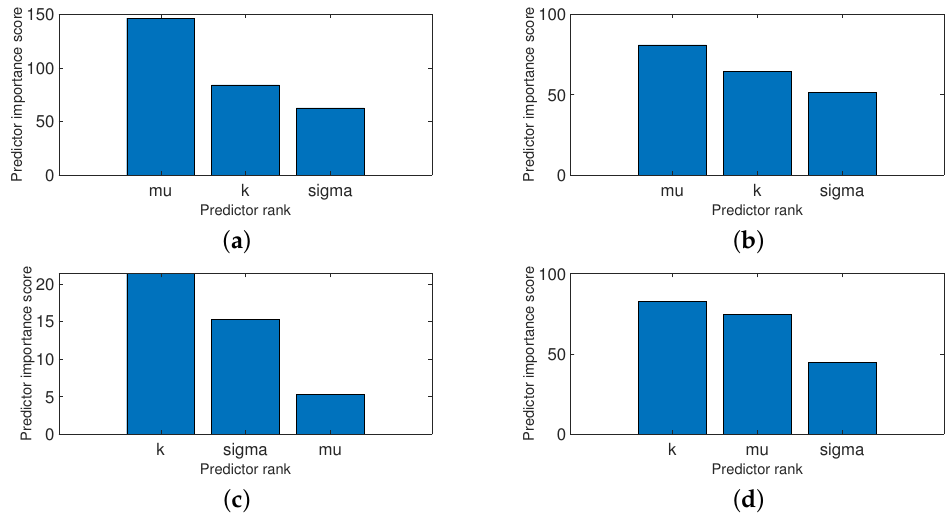
Figure 14. Feature ranking from the raspberries diseases and defects using statistical modeling. ( a ) Albinism. ( b ) Fungus-Rust. ( c ) Over-ripeness. ( d )